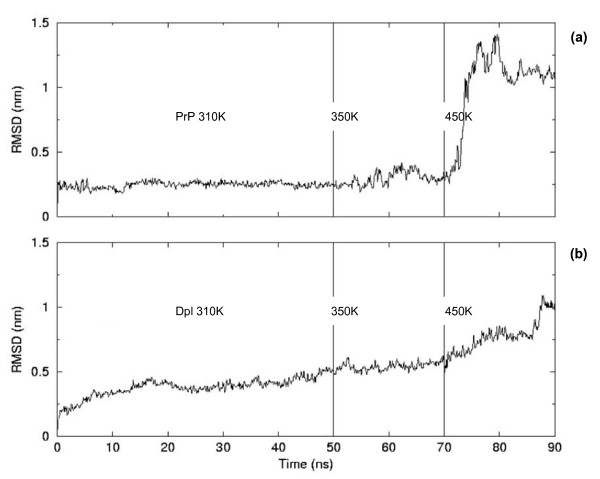
Time evolution of the RMSD from the Native Structure. Time evolution of the Root Mean Square Deviation (RMSD) of the structures sampled from the trajectories from the native structure of PrP (a) and of Dpl (b) during the simulations. Between 0–50 ns the temperature was 310 K; 50–70 ns 350 K; 70–90 ns 450 K.